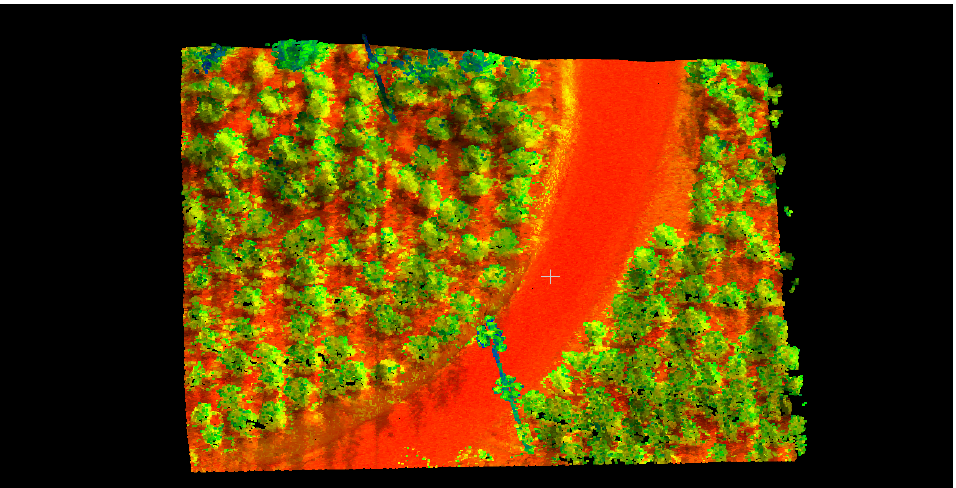
Figure 20. Adding colors to the datasets of Figure